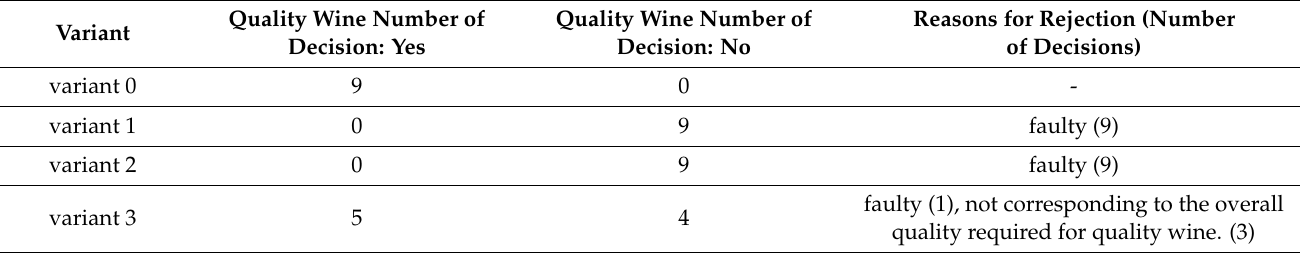
Table 5. The sensory testing of the quality wine status of the four variants of the large-scale trial according to [1,2] * 1 .